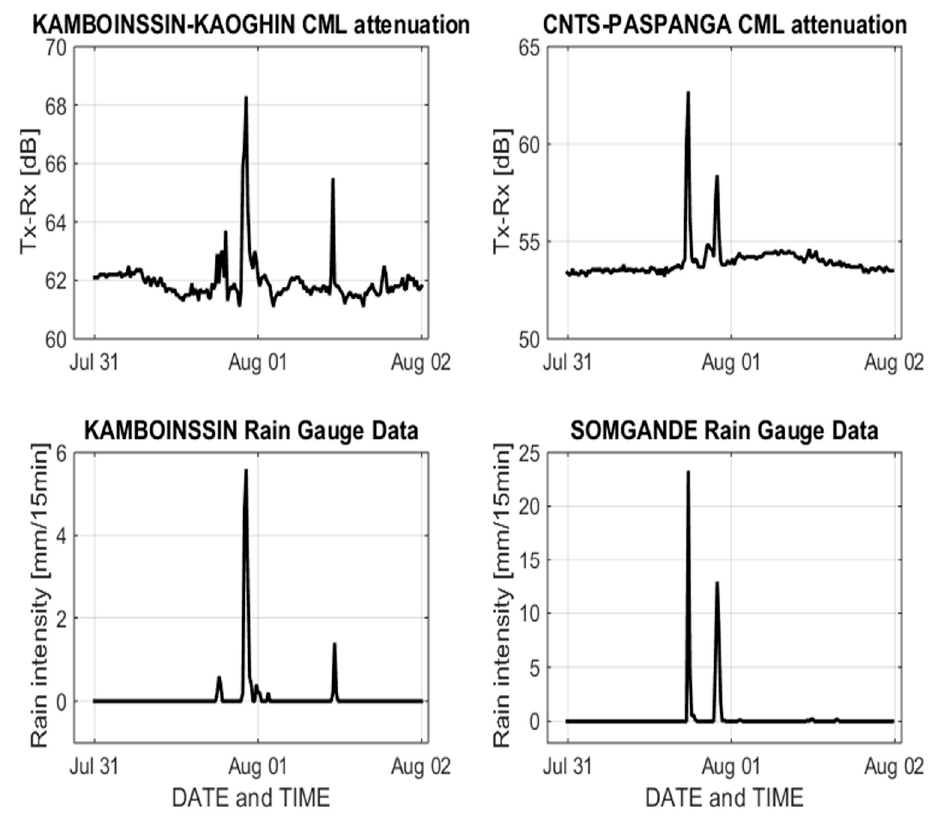
Figure 8. CMLs’ attenuations data and ANAM rain gauge data for the 31 July 2019 and 1 August 2019 rain events .